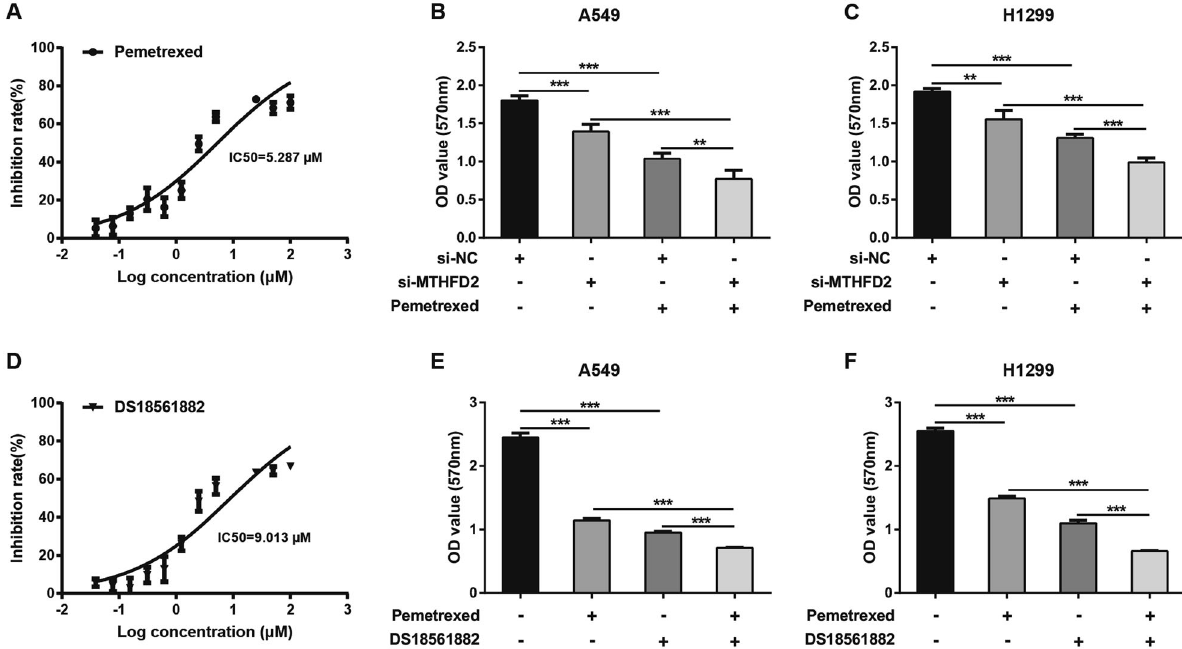
Fig. 7 Speci fi c inhibition of MTHFD2 function improves anti-tumor sensitivities induced by pemetrexed in LUAD. A The IC50 value of pemetrexed. B , C A549 and H1299 cells transfected with si-NC or si-MTHFD2 were co-cultured with or without pemetrexed (5 μ M) for 72 h. Cell proliferative abilities were detected by MTT assay. D The IC50 value of MTHFD2 inhibitor DS18561882. E , F A549 and H1299 cells were treated with pemetrexed (5 μ M), DS18561882 (10 μ M), or combination for 5 days. Cell proliferative abilities were detected by MTT assay. ** P < 0.01, *** P <